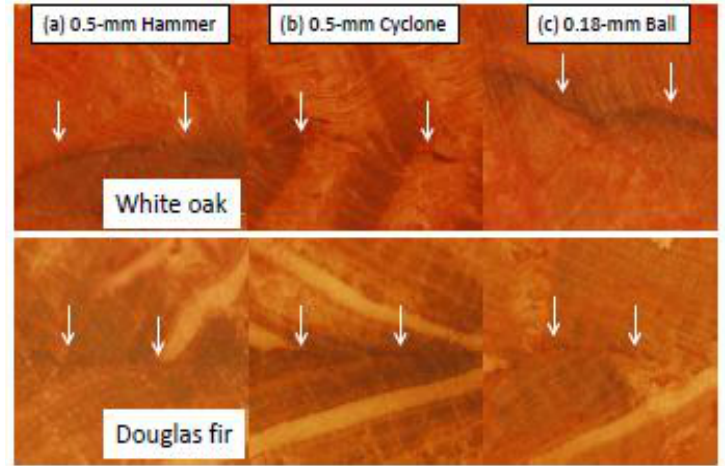
Figure 6. Stereomicroscopic images of white oak and Douglas fir substrates bonded by WCSM products ground by three mills and passed by 0.5-mm and 0.18-mm screens, respectively. For clarity, the horizontal bond line in each image is indicated with two arrows.